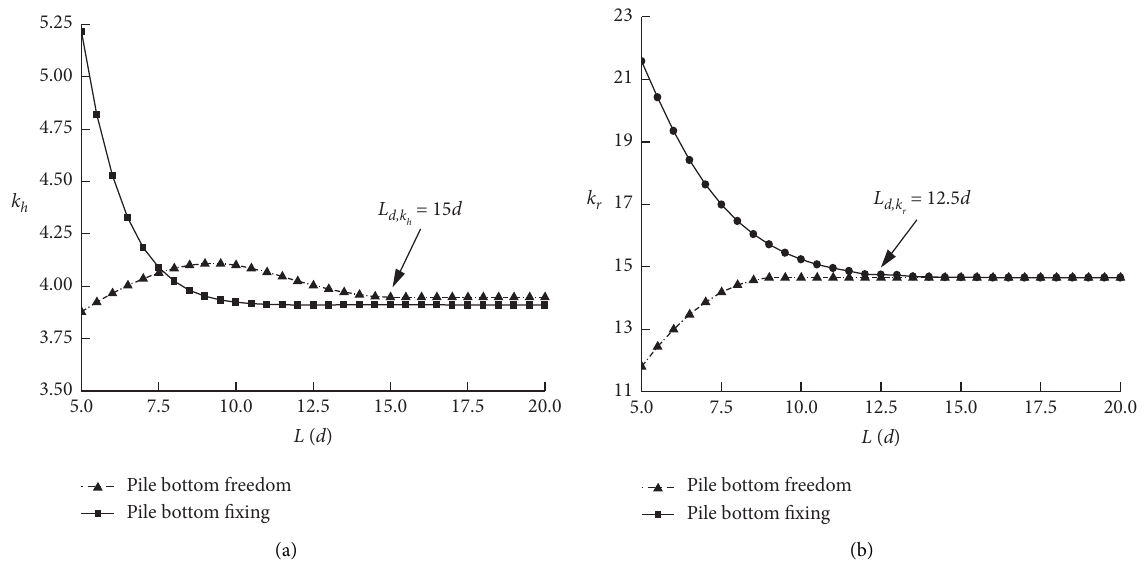
Figure 5: Variation in impedance with boundary conditions at the pile bottom and vertical load. (a) Horizontal dimensionless dynamic stiffness. (b) Rocking dimensionless dynamic stiffness.